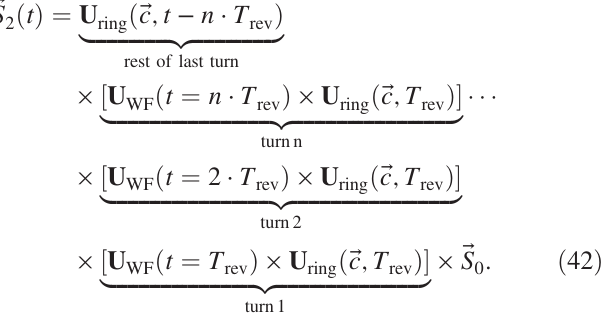
The corresponding situation of the ring is illustrated in Fig. 4. The spin rotations in the ring can be described by U . A turn begins with the revolution in the ring at t ¼ 0 , ring T ; … , n · T , and it ends with one pass through the rev rev rf Wien filter. Between two successive points in time at which a particle encounters the rf Wien filter, its spin is just idly precessing in the machine. Sequential unitary rotations in Eq. (42) manifestly preserve the magnitude of the polarization.